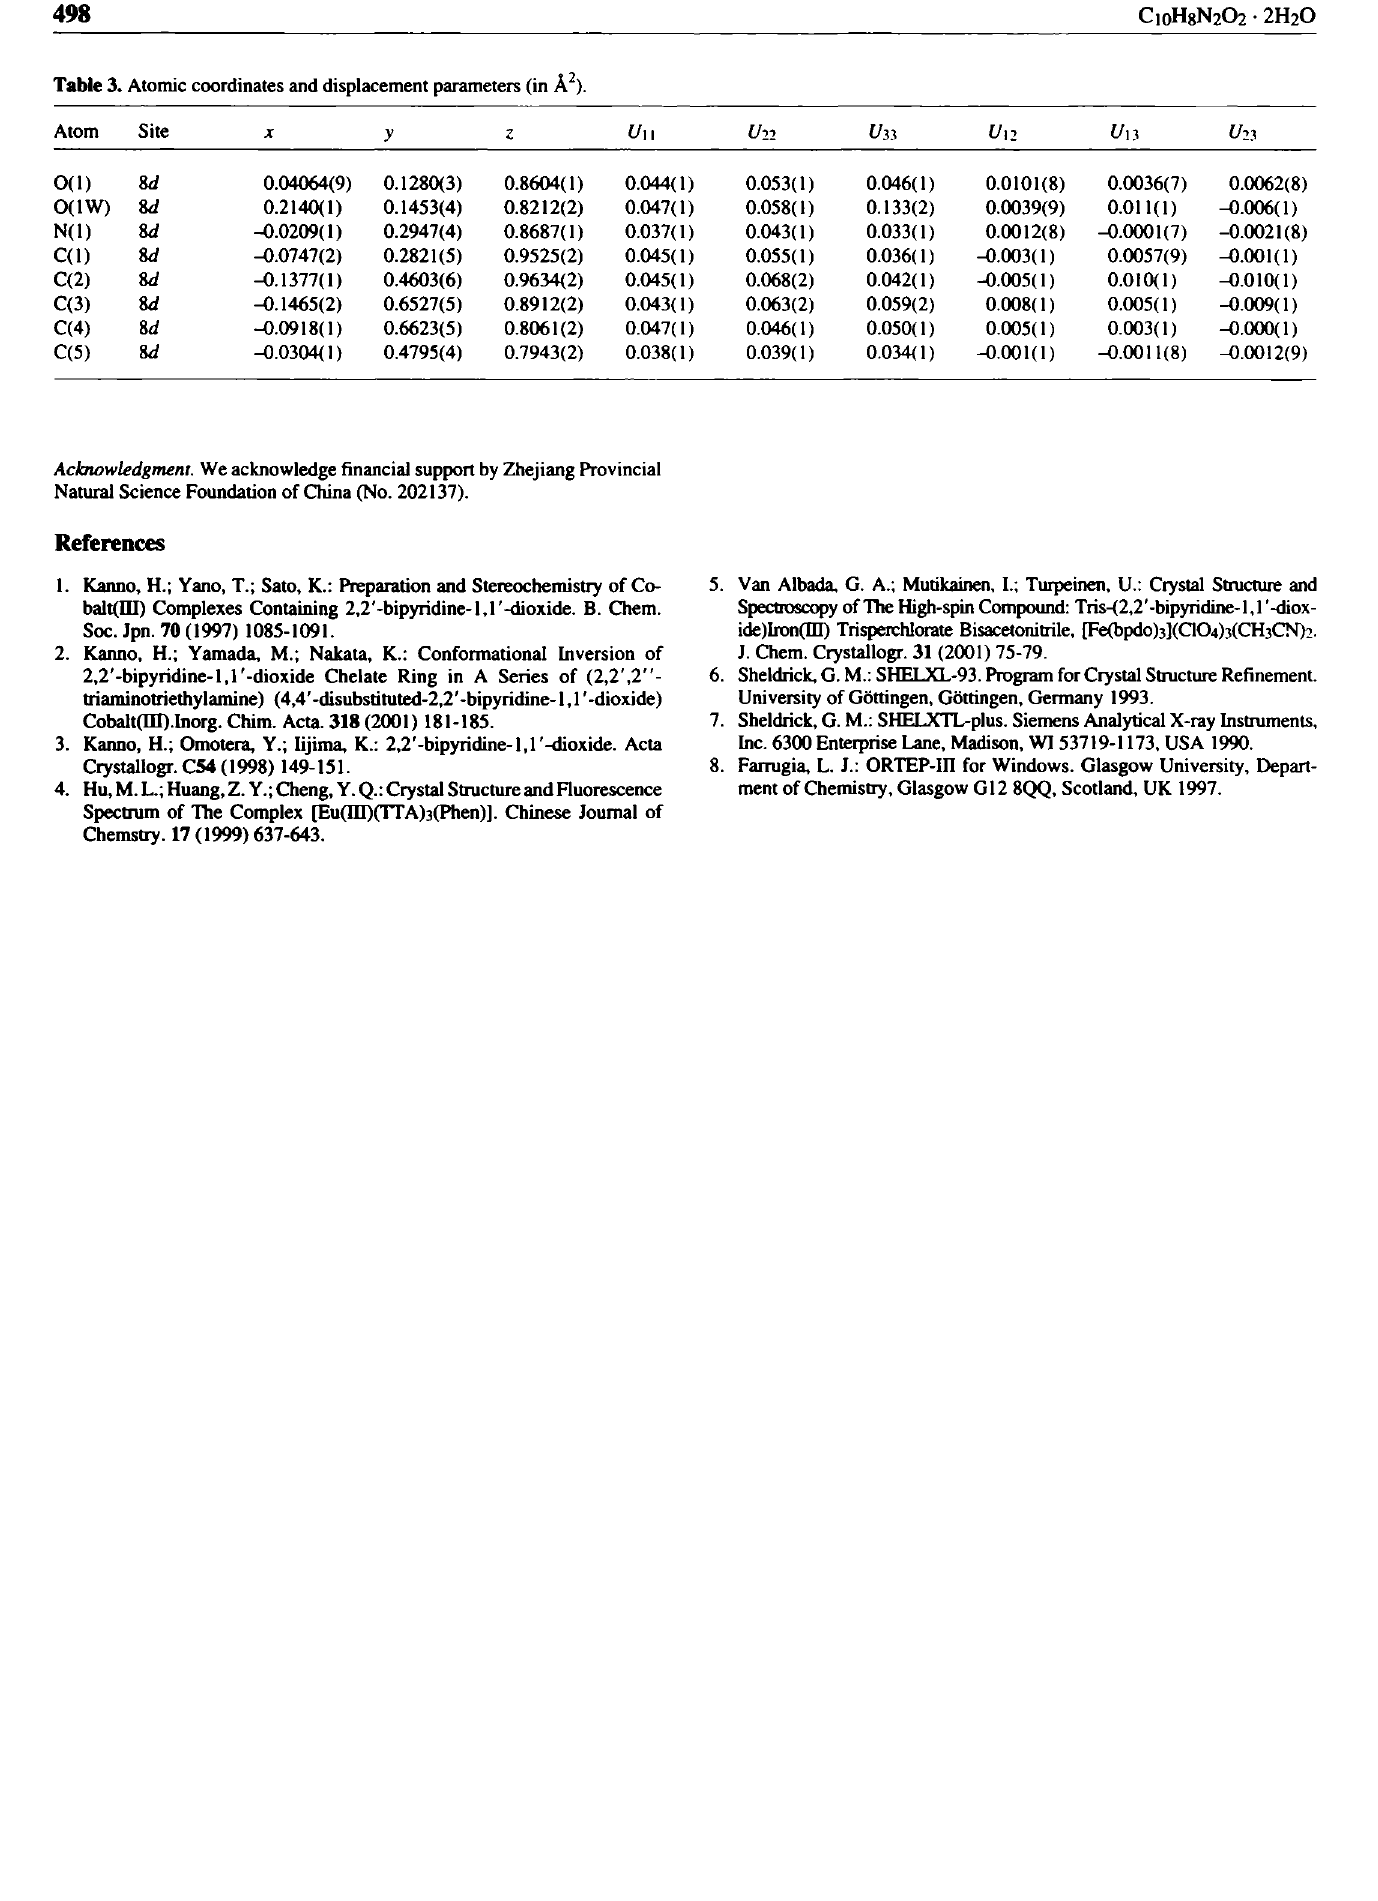
Table 3. Atomic coordinates and displacement parameters (in Â 2